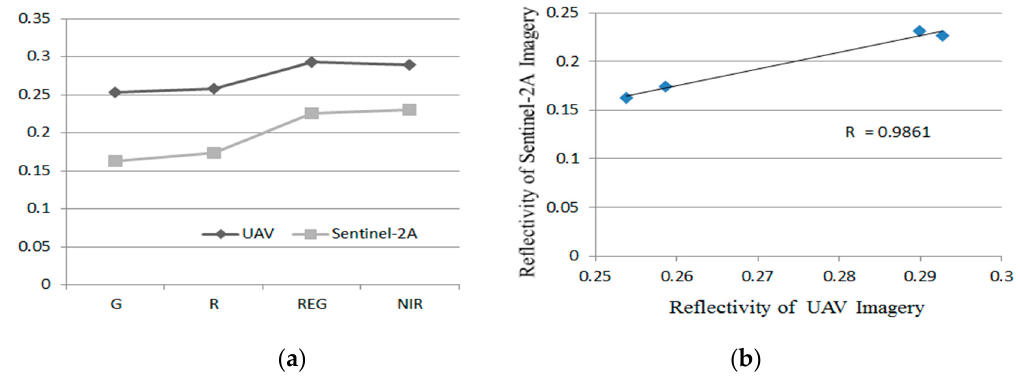
Figure 2. Comparison of surface reflectance between UAV and S2A imagery.